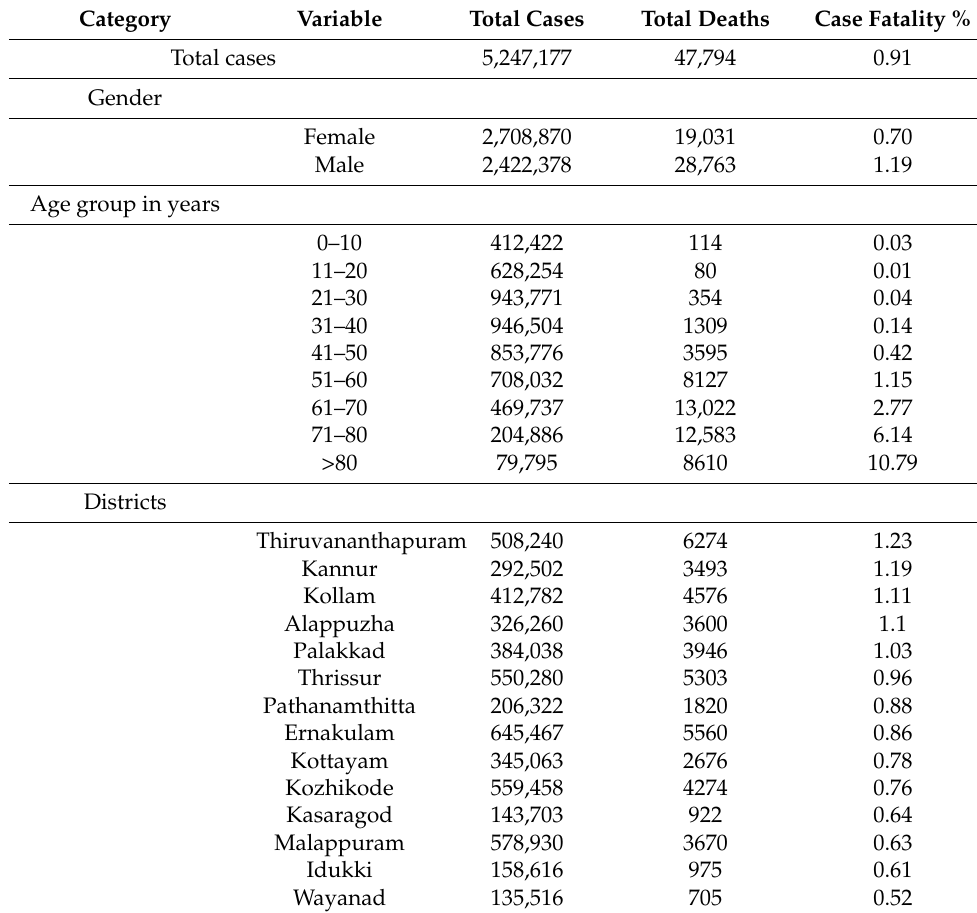
Table 2. Total COVID-19 cases, total deaths, and case fatalities in Kerala,